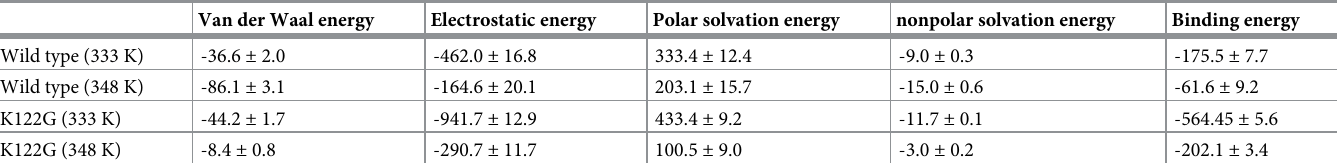
Table 1. The change in binding energy of each component with increasing temperature (from 333 K to 348 K). The unit of energy is